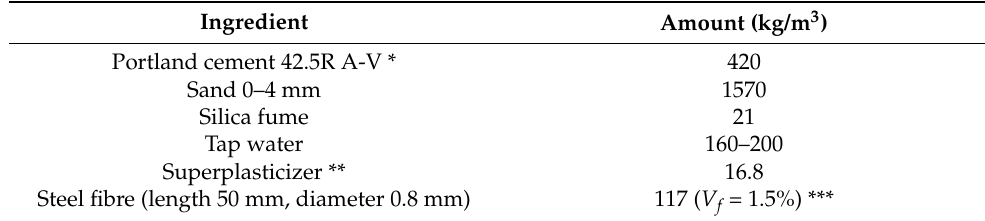
Table 2. Concrete